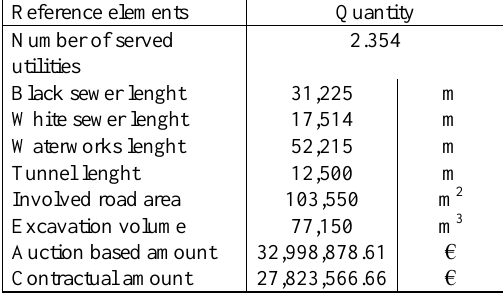
Table 1. Work data (Excerpt 1 – Central Axis)